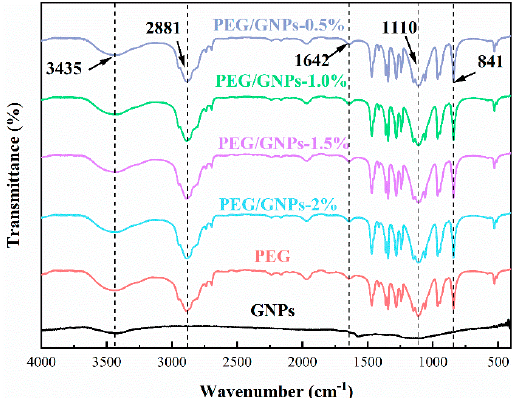
Figure 2. Fourier transform infrared (FT-IR) spectra of GNPs, pure PEG and PEG/GNPs composites with different contents of